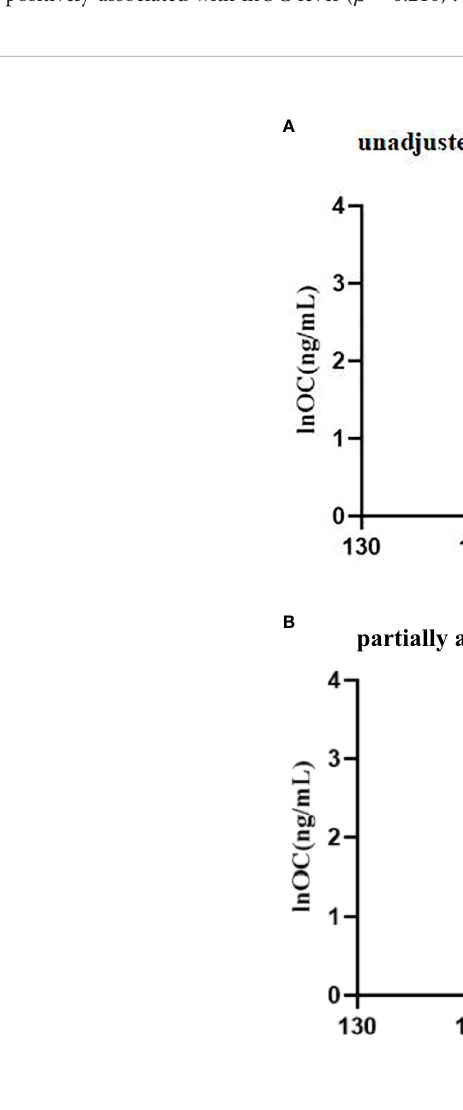
FIGURE 2 The relationship between serum sodium and lnOC in patients with T2D (A) unadjusted; (B) partially adjusted for age, sex, BMI and HbA1